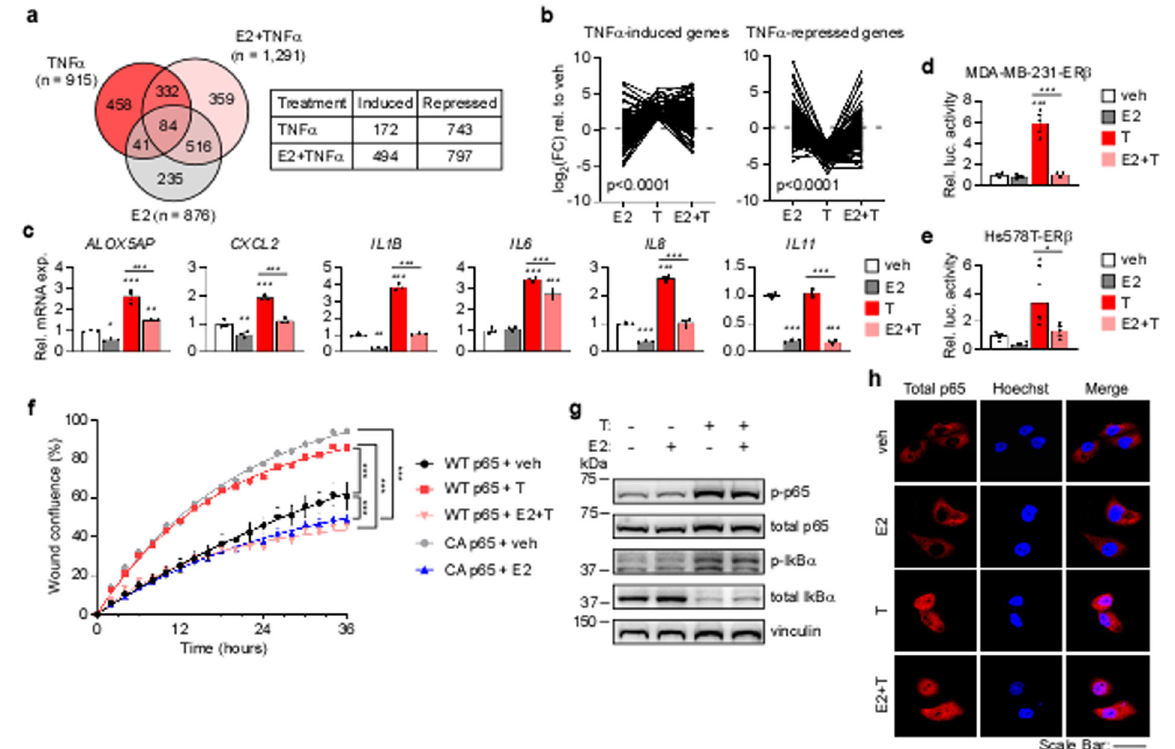
Fig. 3 ER β blocks ligand-mediated activation of canonical NF κ B/p65 signaling and cell migration. a Venn diagram depicting the overlap of genes differentially expressed in dox treated MDA-MB-231-ER β cells following TNF α , E2 + TNF α , or E2 stimulation relative to vehicle control. The number of induced and repressed genes by each treatment is indicated. b Fold change (FC) relative to vehicle of TNF α -induced and -repressed genes following E2, TNF α (T), or E2 + TNF α (E2 + T) treatment (Wilcoxon rank sum test). c RT-qPCR analysis of NF κ B/p65 target gene mRNA expression relative to vehicle in MDA-MB-231-ER β cells treated as indicated in the presence of dox. NF κ B/p65 luciferase reporter activity relative to vehicle in ( d ) MDA-MB-231-ER β and ( e ) Hs578T-ER β cells following indicated treatments in the setting of dox. f Migration assay of dox treated MDA-MB-231-ER β cells and constitutively active p65 cells (CA p65) following veh, T, E2 + T, or E2 treatment. *** P < 0.001 between indicated treatments (non-linear fi t modeling). g Western blot analysis of phospho- and total p65 and I κ B α following indicated treatments in the presence of dox. Vinculin is shown as a loading control. h Confocal microscopy images depicting cellular localization of total p65 in MDA- MB-231-ER β cells following indicated treatments in addition to dox. Hoechst stain used to identify nuclei. Scale bars are equivalent to 50 µm. Data represent mean ± SEM. c – e * P < 0.05, ** P < 0.01, *** P < 0.001 relative to vehicle or between indicated treatments (one-way ANOVA). See also Figure